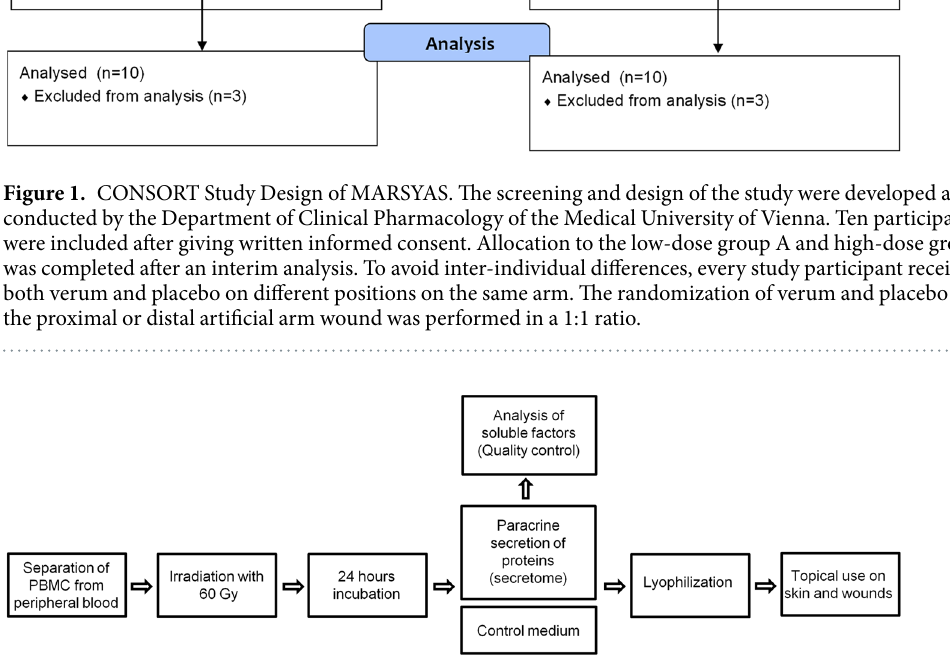
Artificial wounds were generated by two 4-mm punch biopsies (distal and proximal, respectively) on the inner upper side of the non-dominant arm under local anesthesia. The distance between both biopsies was at least 8 cm. After being cleaned with 0.9% NaCl, one wound was treated with approximately 1 ml of APOSEC and the second with approximately 1 ml of placebo according to previous randomization. Wound dressing was applied covering the whole wound area. On the following 6 days, APOSEC and placebo were re-applied daily. At day 7, treatment was terminated, wound closure and scar formation were evaluated, and wounds were closed with a